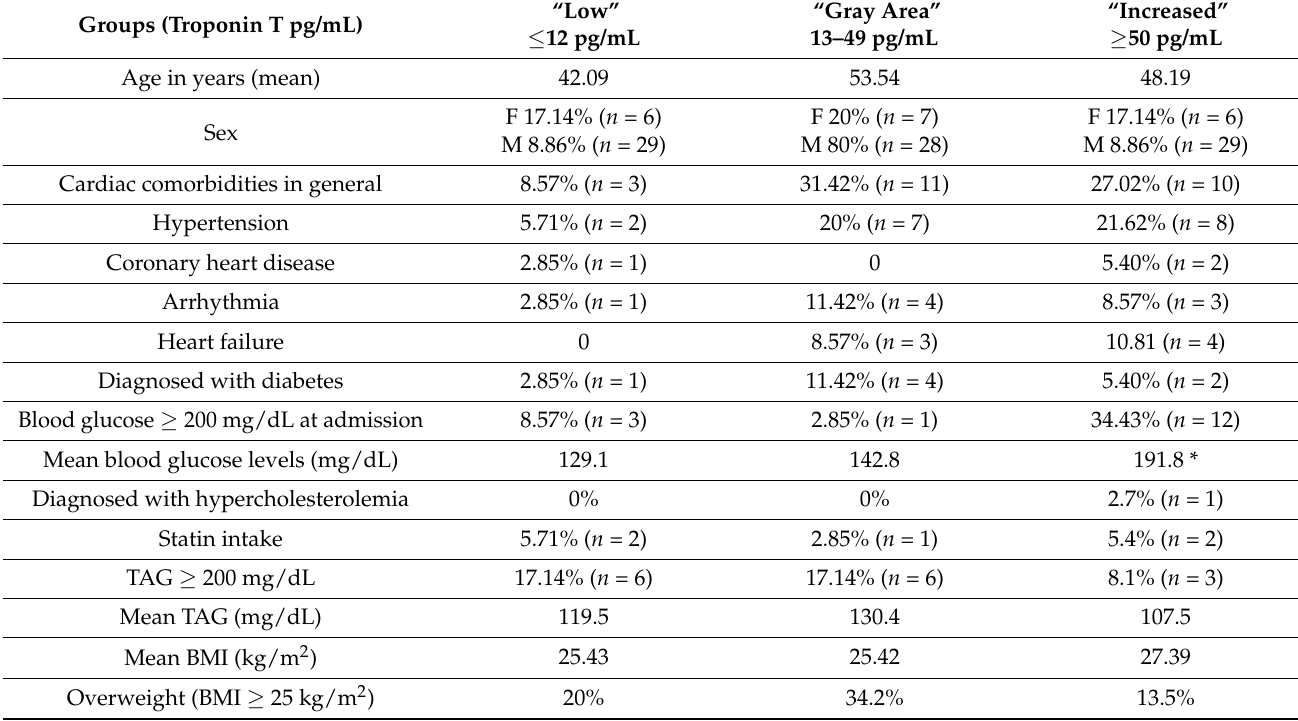
Table 3. Cardiac comorbidities/risk factors in different groups of polytrauma